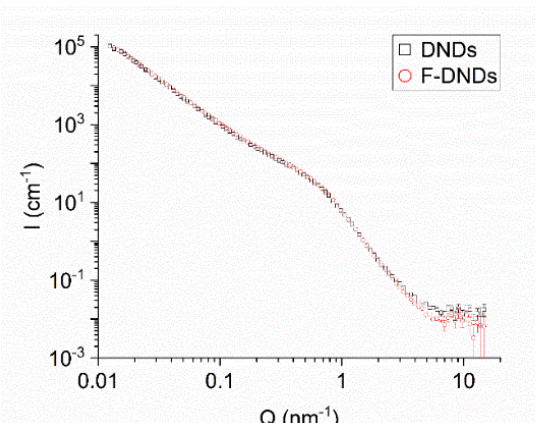
Figure 3. Measured intensity I (cm − 1 ) of scattered neutrons as a function of the transferred momentum Q (cm − 1 ) for DND and F-DND samples shown with black squares and red circles, respectively. For the convenience of comparing the results, the data are normalized to the equal sample mass.